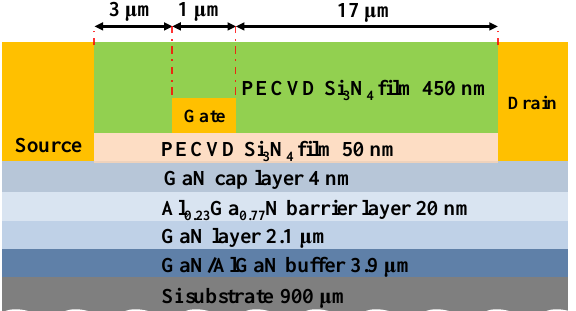
Figure 2. Schematic structure of the AlGaN/GaN high electron mobility transistors (HEMTs) grown on 4-inch Si substrate.